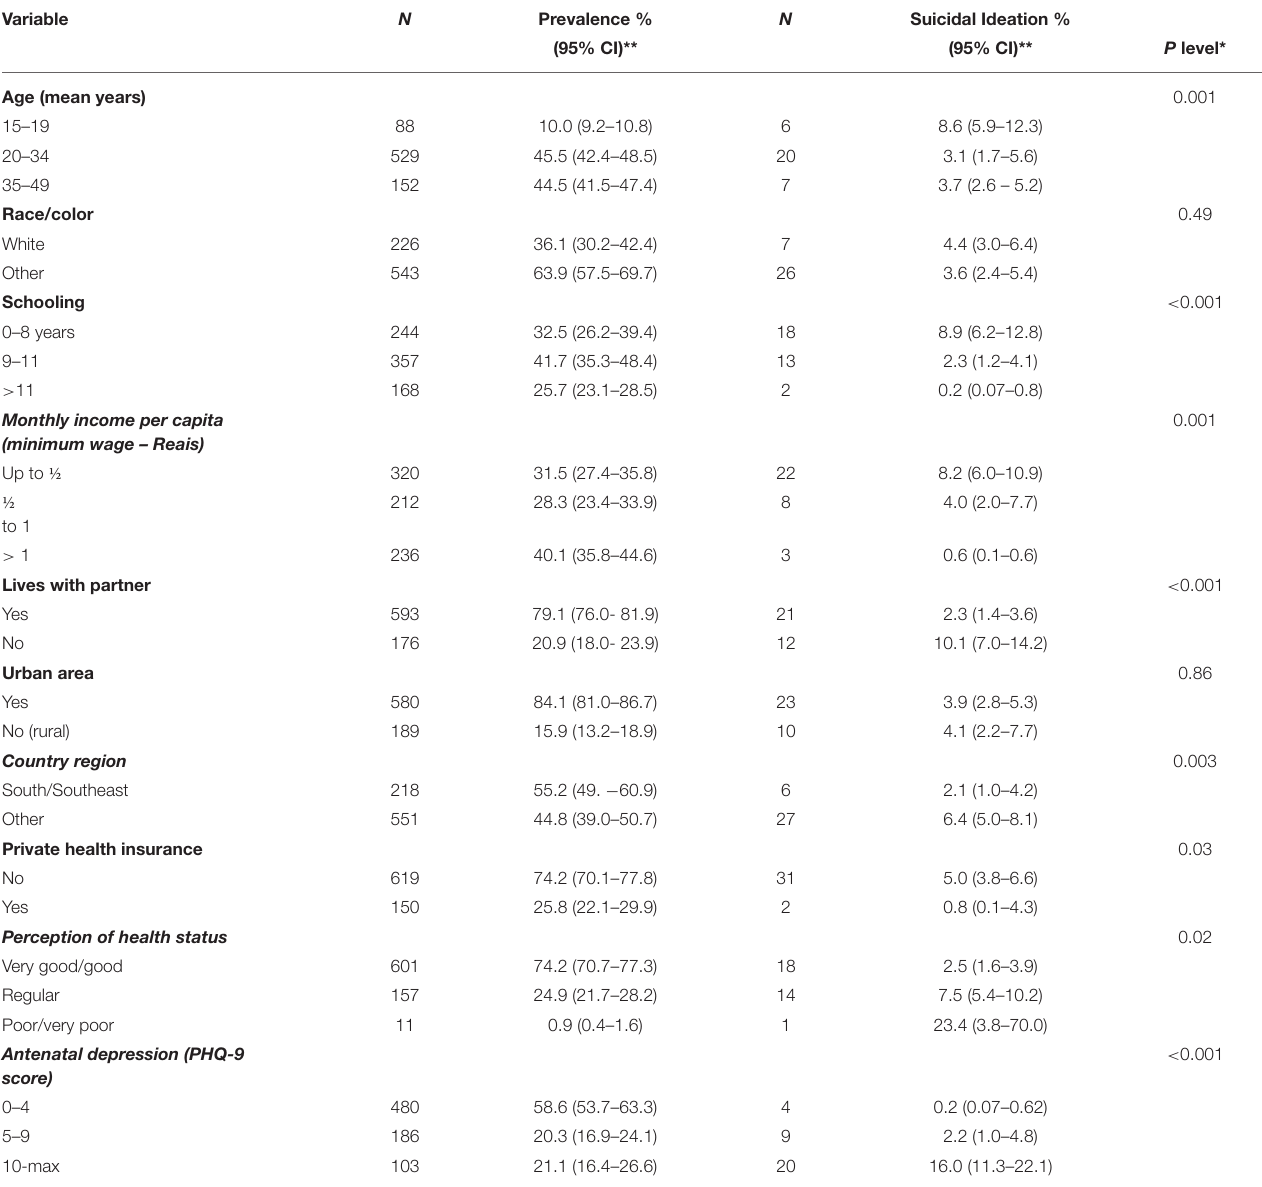
TABLE 1 | Characteristics of suicidal ideation among pregnant women in the Brazilian National Survey of Health, 2019.